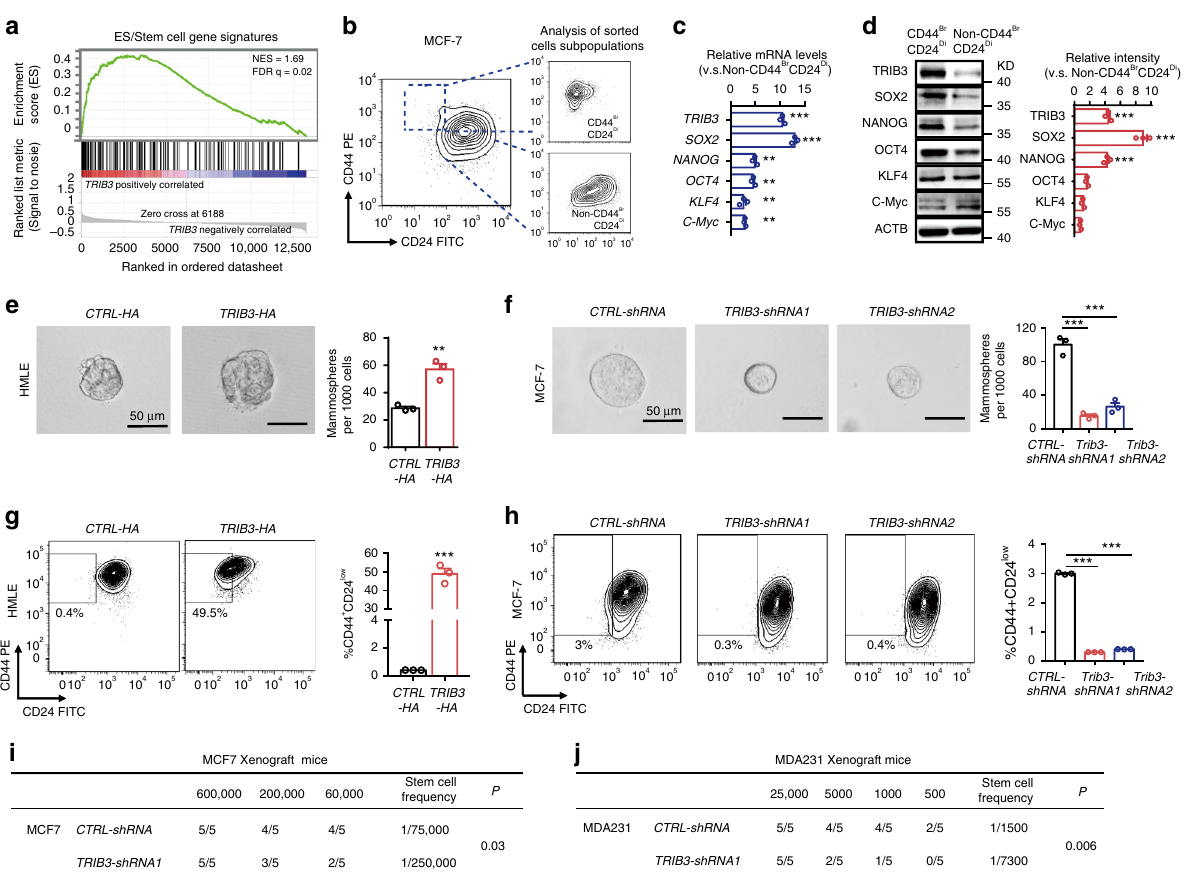
Fig. 2 Silencing TRIB3 inhibits the spheroid formation and tumor engraftment. a GSEA demonstrating the enrichment of gene sets related to ES stem cell gene signatures in the ranked gene list of the top 10th percentile ( n = 121) vs. the bottom 10th percentile ( n = 121) of breast cancer patients expressing TRIB3 from the TCGA database ( n = 1215). NES, normalized enrichment score. FDR, false discovery rate. b Flow cytometric analyses of representative unsorted MCF7 cells (left), isolated CD44 Br CD24 Di MCF7 cells (upper right), and isolated non-CD44 Br CD24 Di MCF7 cells (lower right). Contour plots (10% probability) depict the fl uorescence of BCCs stained with fl uorochrome-conjugated mAbs speci fi c for human CD44 (y axis) or human CD24 (x axis). c , d Gene expression ( c ) by real-time PCR or immunoblots ( d ) of protein lysates of CD44 Br CD24 Di and non-CD44 Br CD24 Di MCF7 cells. The height of each column in the histogram indicates the fold increase in each gene or protein, as indicated on the left, of sorted CD44 Br CD24 Di MCF7 cells relative to that of sorted non-CD44 Br CD24 Di MCF7 cells. e , f Tumor spheroid formation of HMLE cells ( e ) transfected with control vector or TRIB3-expressing vector (as indicated at the top) or MCF7 cells ( f ) transfected with either CTRL-shRNA or TRIB3-shRNA . All data are shown as the number of mammospheres per 1000 cells. g , h Flow cytometric assays detecting the percentage of CD44 Br CD24 Di in HMLE cells transfected with a control vector or a TRIB3-expressing vector ( g ), or MCF7 cells transfected with either CTRL-shRNA or TRIB3-shRNA ( h ). i , j Tumor incidence in animals implanted with MCF7 cells ( i ) or MDA- MB-231 cells ( j ) transfected with either CTRL-shRNA or TRIB3-shRNA . Data are shown as the mean ± SEM; P > 0.05 was considered not signi fi cant (NS); * P < 0.05, ** P < 0.01, and *** P < 0.001, compared with the vector or CTRL-shRNA group. Source data are provided as a Source Data fi TRIB3 enhances SOX2 expression via FOXO1 transcription . SOX2, and NANOG was found in CD44 Br CD24 Di cells than that in non-CD24 Di CD44 Br cells (Fig. 2d). Moreover, Trib3 -silenced We examined the expression of stemness-associated proteins in MECs from MMTV-PyMT transgenic mice and MMTV-ErbB2 TRIB3-negative HMLE cells overexpressing TRIB3 (Fig. 3a top and Fig. 3b) and TRIB3-positive MCF7 (Fig. 3a bottom and Fig. 3c) and MDA-MB-231 (Supplementary Fig. 3a, b) cells in negative HMLE cells with TRIB3 enhanced spheroid formation which TRIB3 expression was silenced. Overexpression of TRIB3 in HMLE cells dramatically enhanced the mRNA expression of SOX2 TRIB3-silenced cells exhibited a reduced capacity for spheroid (Fig. 3a top) and promoted protein expressions of SOX2, NANOG, and c-Myc (Fig. 3b). Silencing TRIB3 expression in MCF7 cells attenuated the mRNA expressions of SOX2 and POU5F1 (Fig. 3a bottom) and protein expressions of SOX2 and NANOG (Fig. 3c); in MDA-MB-231 cells, silencing TRIB3 expression intensively attenuated the mRNA expression of SOX2 and KLF4 (Supplementary Fig. 3a), and inhibited protein expression of SOX2 and c-Myc (Supplementary Fig. 3b). SOX2 was universally correlated with TRIB3 expression in all three types of cells. Moreover, silencing SOX2 but not other pluripotency